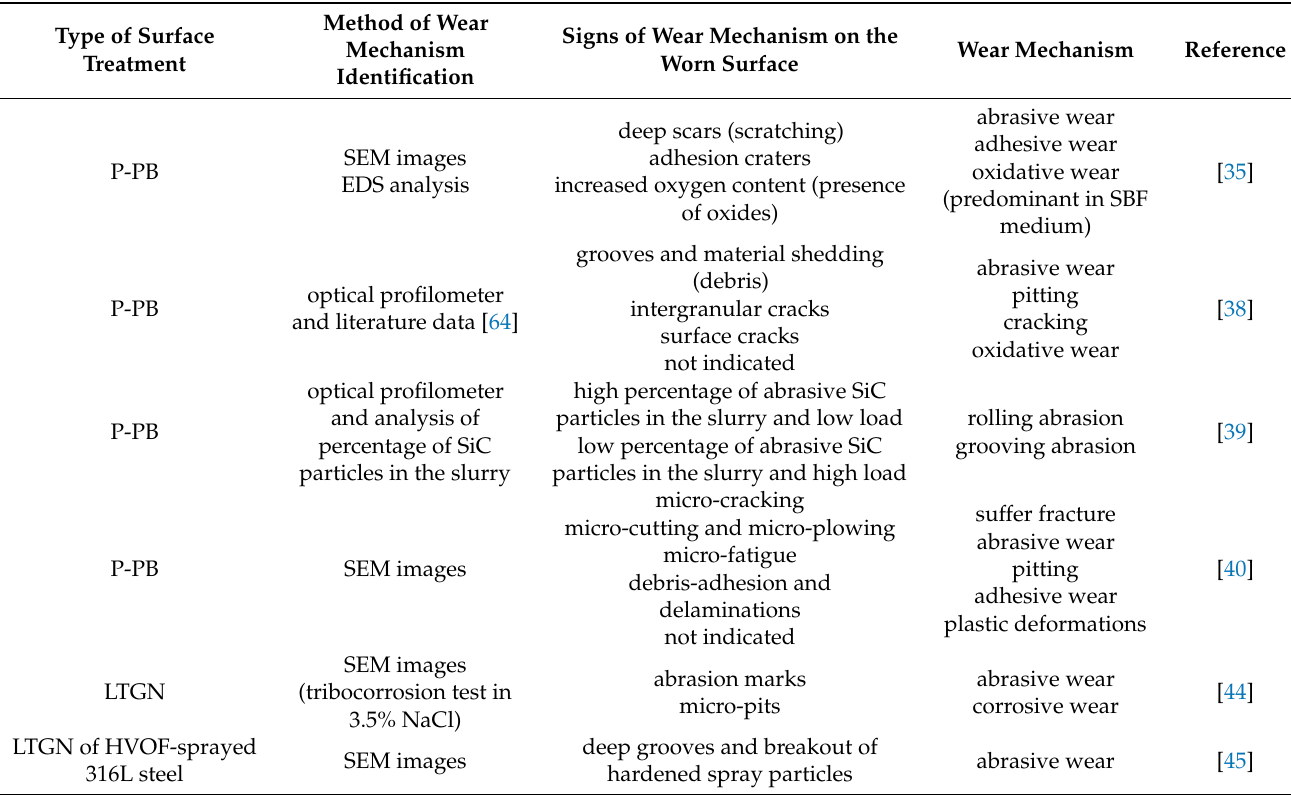
Table 6. Wear mechanisms of the surface layers produced by various thermochemical